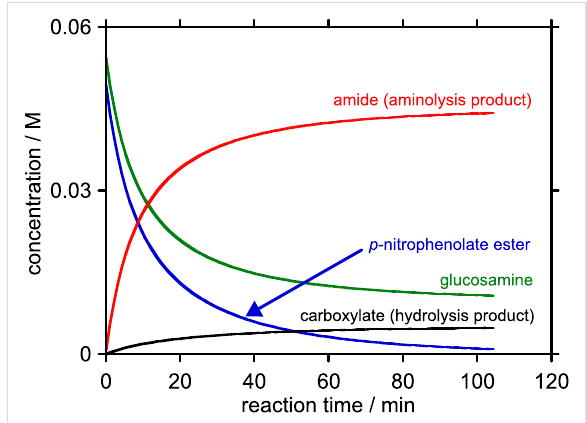
Figure 3: Predicted concentration-time profile for the reaction between starting concentrations of 0.05 M p -nitrophenyl ester 7 (R = p NP) and